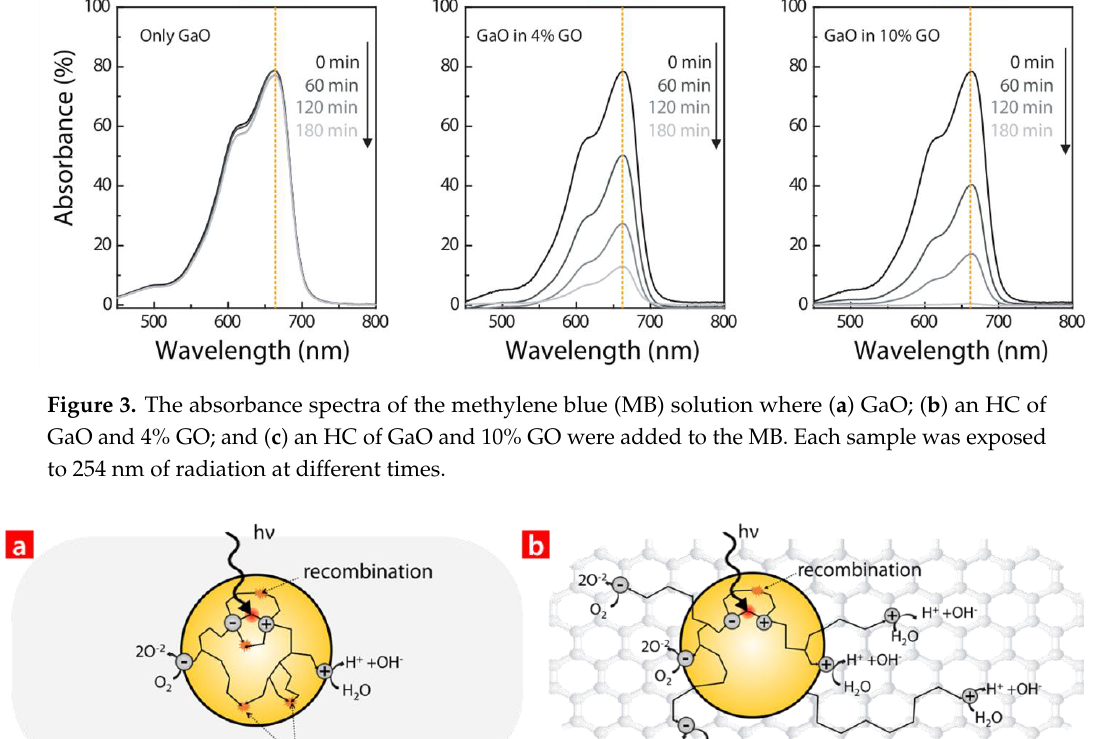
Figure 4. Schematic illustrations of charged carrier generation and transfer, as well as the water splitting mechanism of ( a ) the Ga oxide and ( b ) the HC of Ga oxide and GO. hν is ultraviolet light energy, where h is Planck’s constant and ν is frequency.